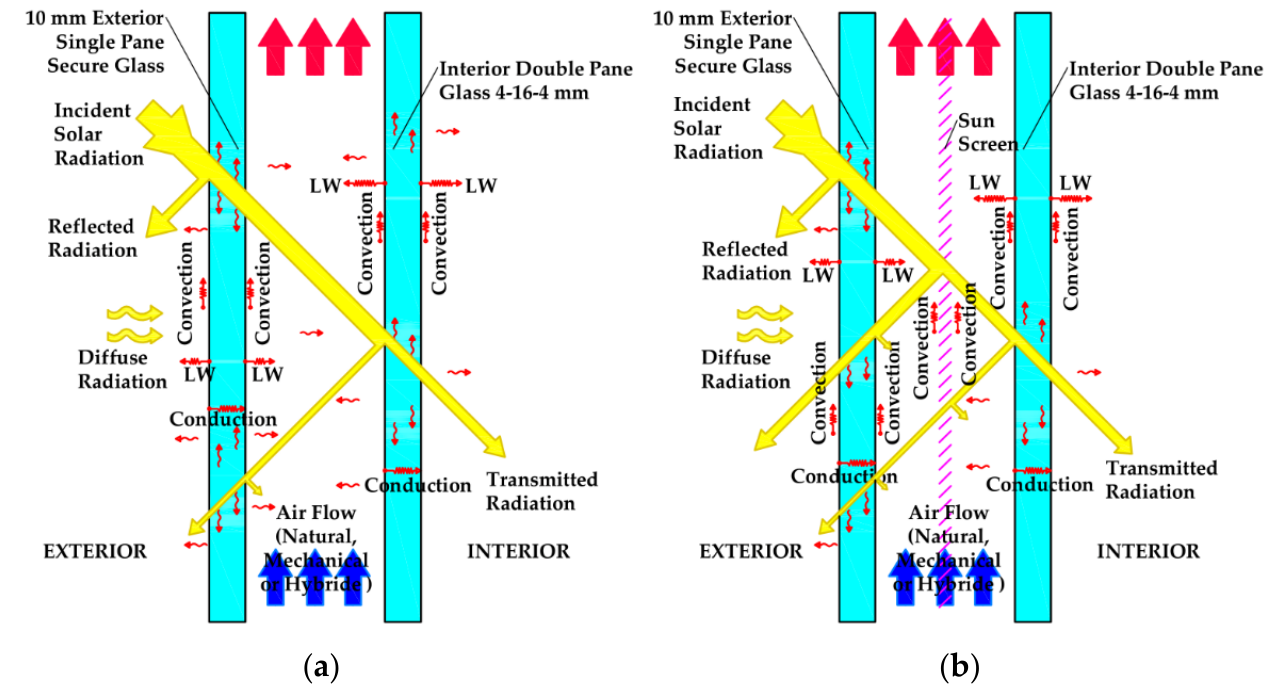
Figure 1. Heat transfer and air circulation through a double glass façade: the simple version, without shading devices ( a ) and the variant with a shading device positioned in the middle of the cavity ( b ).